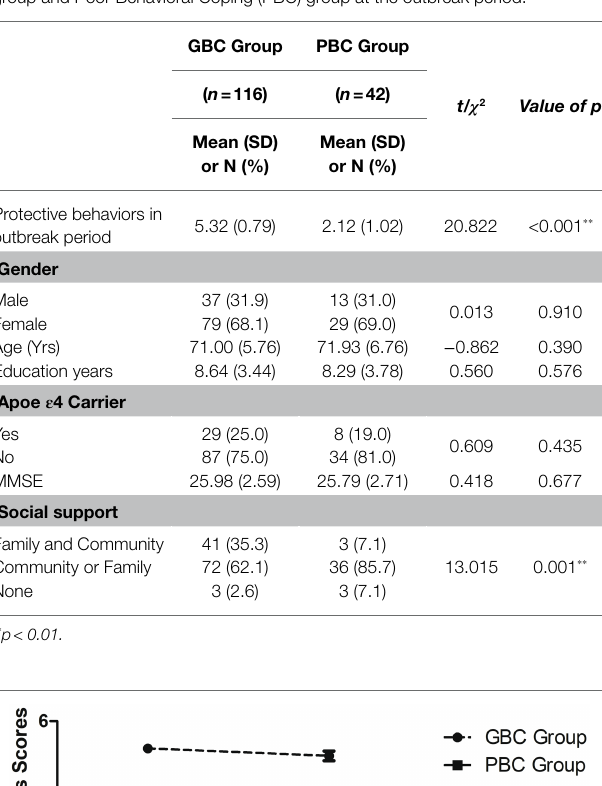
TABLE 5 | Participant characteristics of the Good Behavioral Coping (GBC) group and Poor Behavioral Coping (PBC) group at the outbreak period.